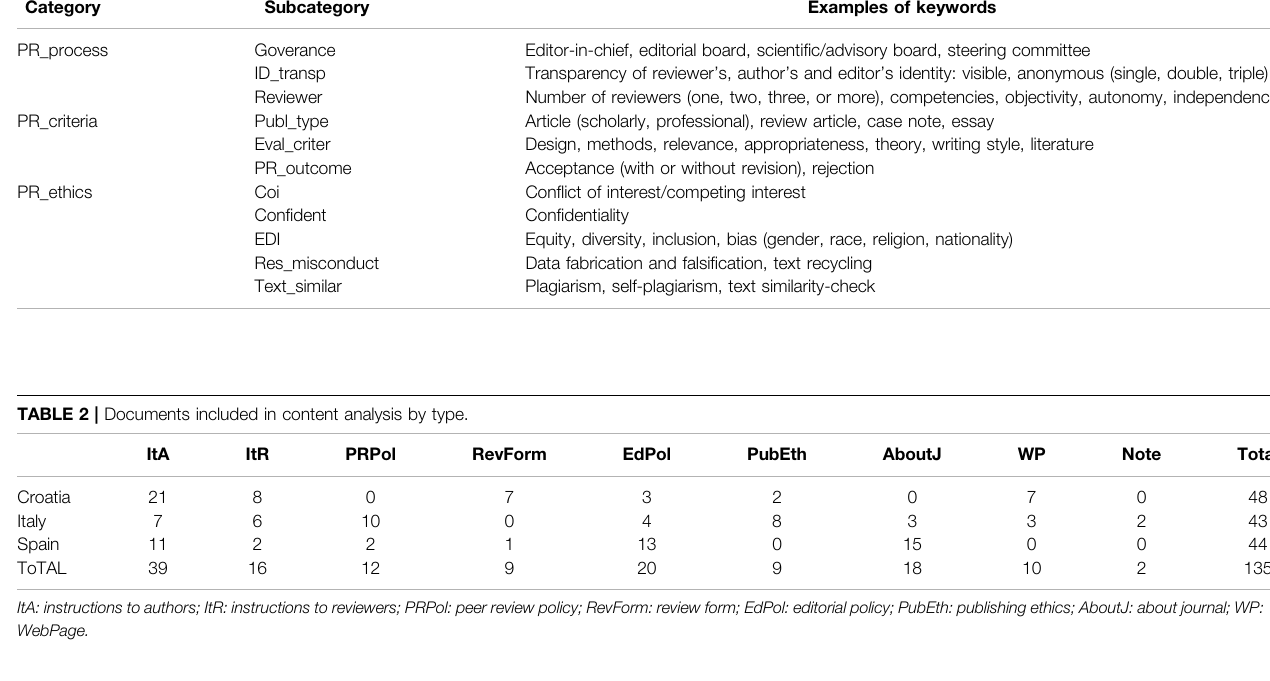
TABLE 1 | A simpli fi ed version of the peer review categorization dictionary. Category